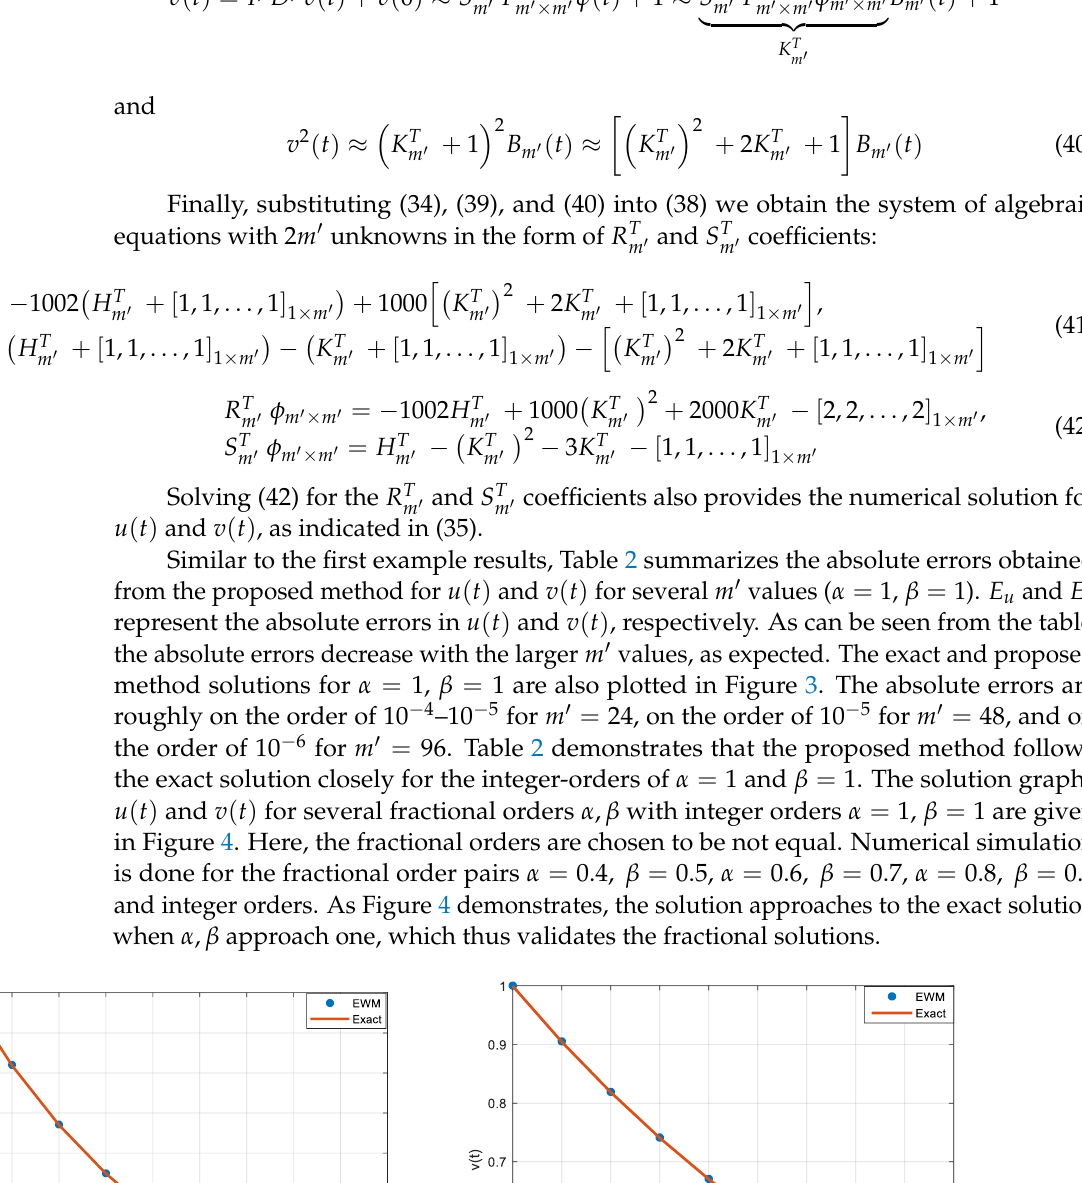
Figure 3. Numerical and exact solutions of u ( t ) and v ( t ) for α = 1, β = 1 for Example 2 ( m (cid:48) = 1 2 ).